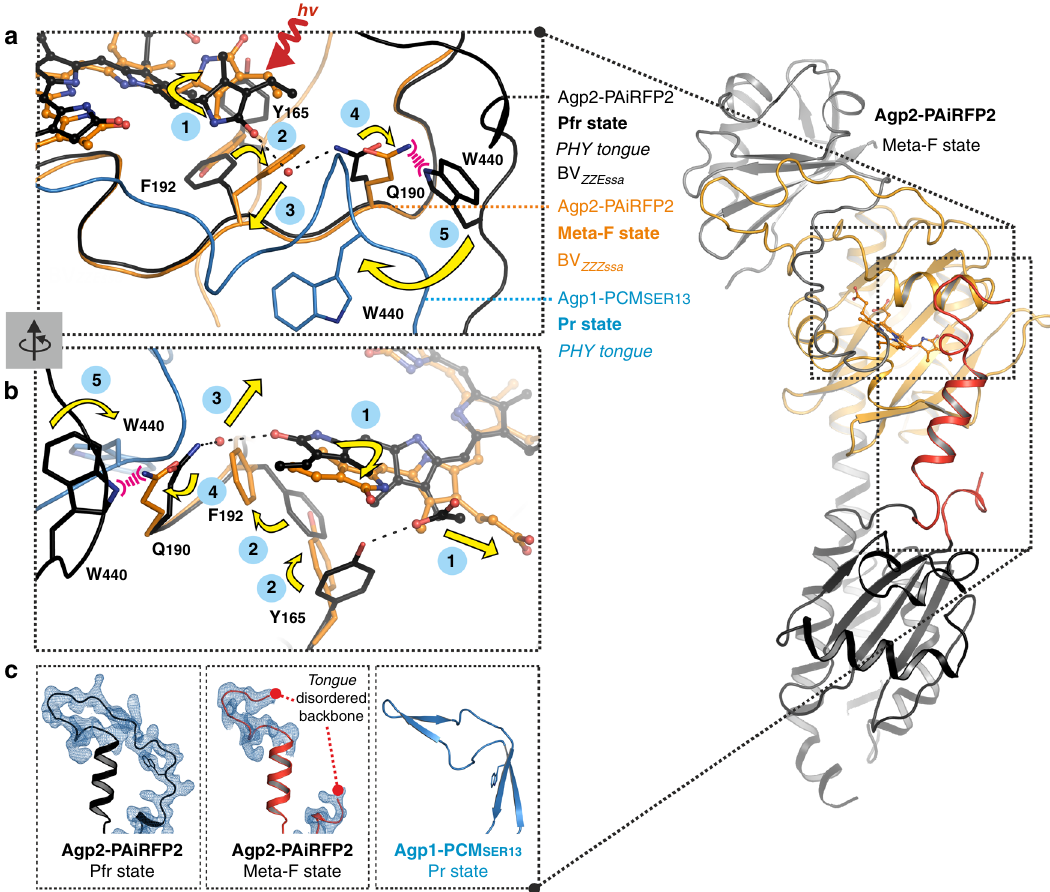
Fig. 9 Proposed structural mechanism for the sequence of events during Pfr-to-Pr photoconversion. The upper and middle left panels ( a , b ) show the relevant section of a superposition of the structures of Pfr (Agp2-PAiRFP2, PDB entry 6G1Z, black), Meta-F (Agp2-PAiRFP2, PDB entry 6G20 (Mol A), orange, PHY tongue in red) and Pr (Agp1-PCM SER13 , PDB entry 5HSQ 30 , blue) for comparison. Amino acid residues Tyr165, Gln190, Phe192 and Trp440 (Agp2-PAiRFP2 numbering) are shown as sticks, BV is depicted as balls and sticks. Following ( 1 ) E → Z photoisomerization of BV (Pfr → Lumi-F) and the subsequent chromophore relaxation, the rearrangement of the hydrogen bond network and the rotated ring D induces ( 2 ) the reorientation of the side chains of Phe192 and Tyr165 such that their aromatic rings form a hydrophobic pocket with ring D. Thus ( 3 ) the water molecule Wat758 (red sphere) at ring D is displaced, accompanied by ( 4 ) a positional shift of Gln190 in the Meta-F intermediate, which has a direct impact on the PHY tongue. In the Pfr state, the highly conserved Trp440 of the PHY tongue overlaps with the position of this shifted Gln190 (Meta-F state). Therefore, steric hindrance by Gln190 ( 5 ) would cause Trp440 to move and eventually affect the PHY tongue (Agp2-PAiRFP2) in Meta-F to induce refolding upon transition to the Pr state. c In Agp2-PAiRFP2 (left panel), Trp440 is part of the tongue segment that is disordered in Agp2-PAiRFP2 Meta-F (middle panel). For comparison, Agp1-PCM SER13 shows an ordered segment and a β -sheet in this region (Nd-YAG cw laser, line width 1cm − 1 ), equipped with a nitrogen-cooled cryostat from Resultec (Linkam). All spectra of the samples in frozen solution were recorded at 90K with a laser power at the sample of 780 mW with a typical accumulation time of 1h. In order to identify potential laser-induced damage of the phytochrome samples, spectra before and after a series of measurements were compared. In no case, changes between these control spectra were determined. Protein and buffer Raman bands were subtracted on the basis of a Raman spectrum of apo-phytochrome. The intermediate states Lumi-F and Meta-F were accumu- lated by 785 nm irradiation of the Pfr sample at 133 and 243K, respectively. Residual contributions of non-photolysed Pfr to the RR spectrum measured at 90 K were subtracted. The spectra of the Pr state were obtained as described elsewhere 17,58 . RR measurements of single protein crystals were performed using a Ramanscope III Raman microscope connected to the RFS-100 FT-Raman spec- trometer (Bruker Optics) via an optical fi bre. The laser power of the 1064 nm excitation line was set to 200 mW at the sample. Protein crystals of the dark (Pfr) or photoinduced states (Meta-F) were measured at 90 K 59 . For IR spectroscopic measurements, the protein samples were placed between two BaF 2 (CaF 2 ) windows (15/20 mm diameter) with a 3- μ m-thick PTFE spacer and equilibrated at 273 K. IR spectra were recorded in a Bruker IFS66v/s or IFS28 spectrometer equipped with a liquid nitrogen cooled MCT detector (J15D series, EG&G Judson). Spectra were recorded 2min prior to illumination and 30s after the illumination and subsequently the Pr-minus-Pfr difference spectra were calculated by subtracting the Pfr spectra from the Pr spectra.